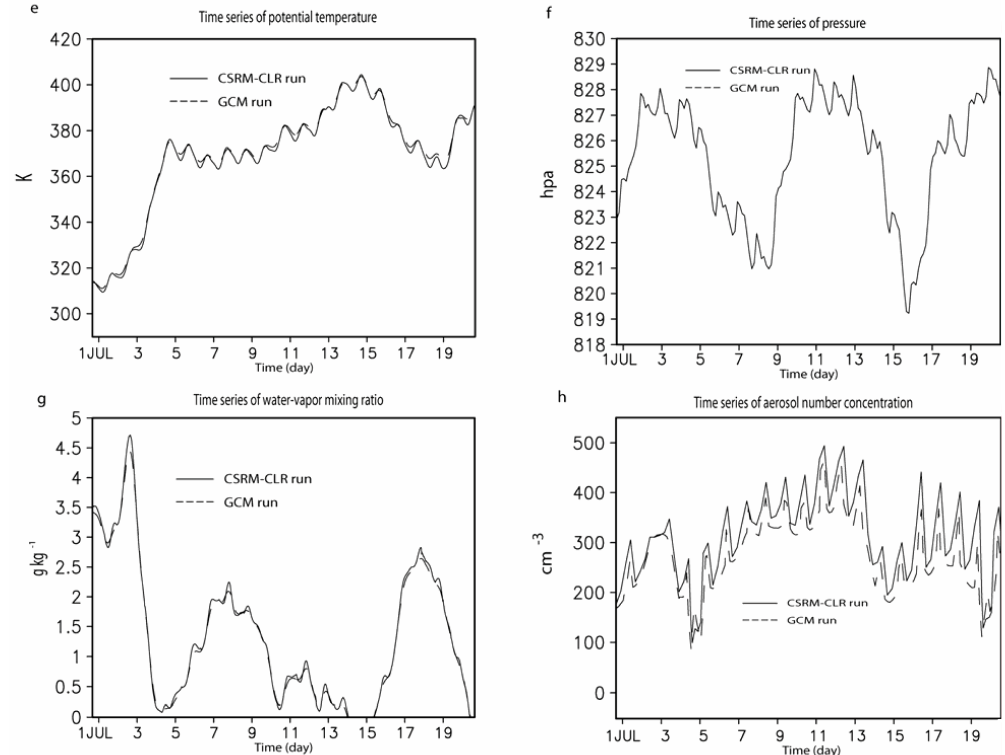
Fig. 6. Time series of domain-averaged (over the lowest 2km) (a) net shortwave fluxes, (b) net longwave fluxes, (c) u wind velocity, (d) v wind velocity, (e) potential temperature, (f ) pressure, (g) water-vapor mixing ratio, and (h) aerosol number concentration for the CSRM-CLR run and the GCM run at (40 ◦ N, 123 ◦ W). In (a) and (b), minus and plus indicate downward and upward fluxes,